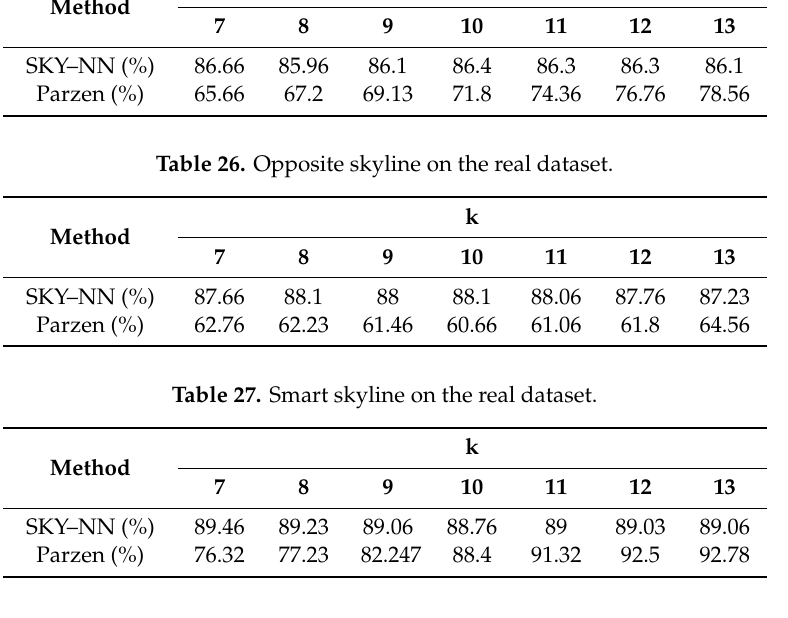
Table 24. Single skyline on the real dataset.